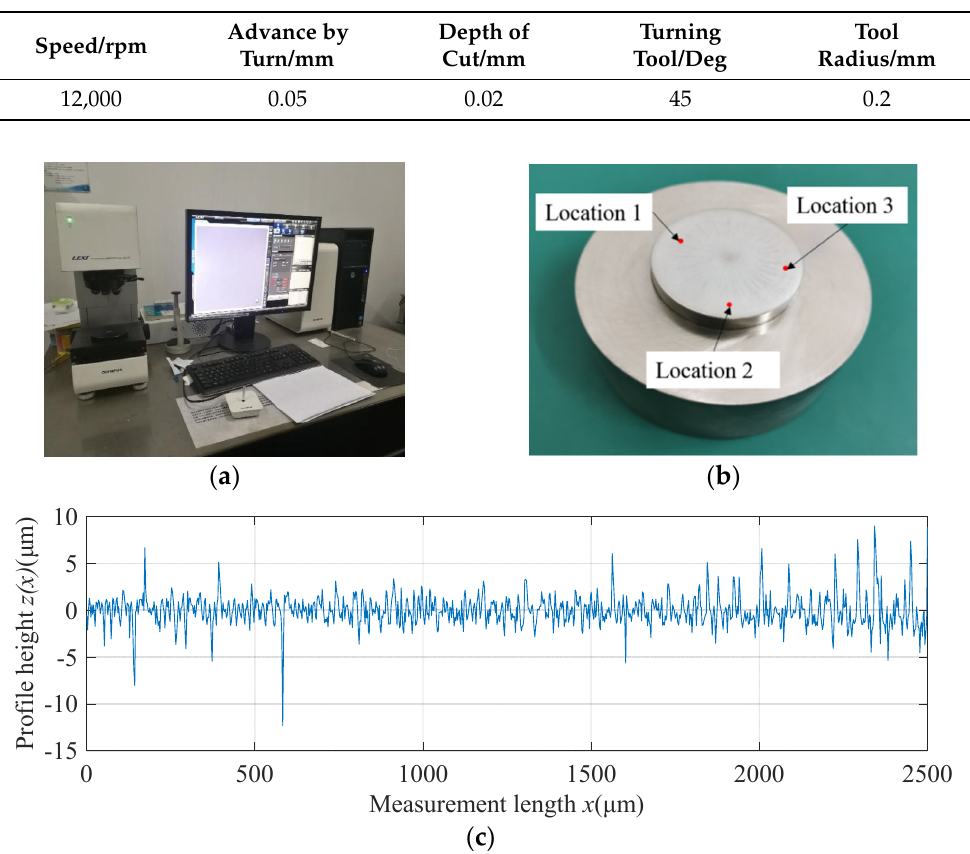
Table 2. Turning processing parameters of the metal surface.